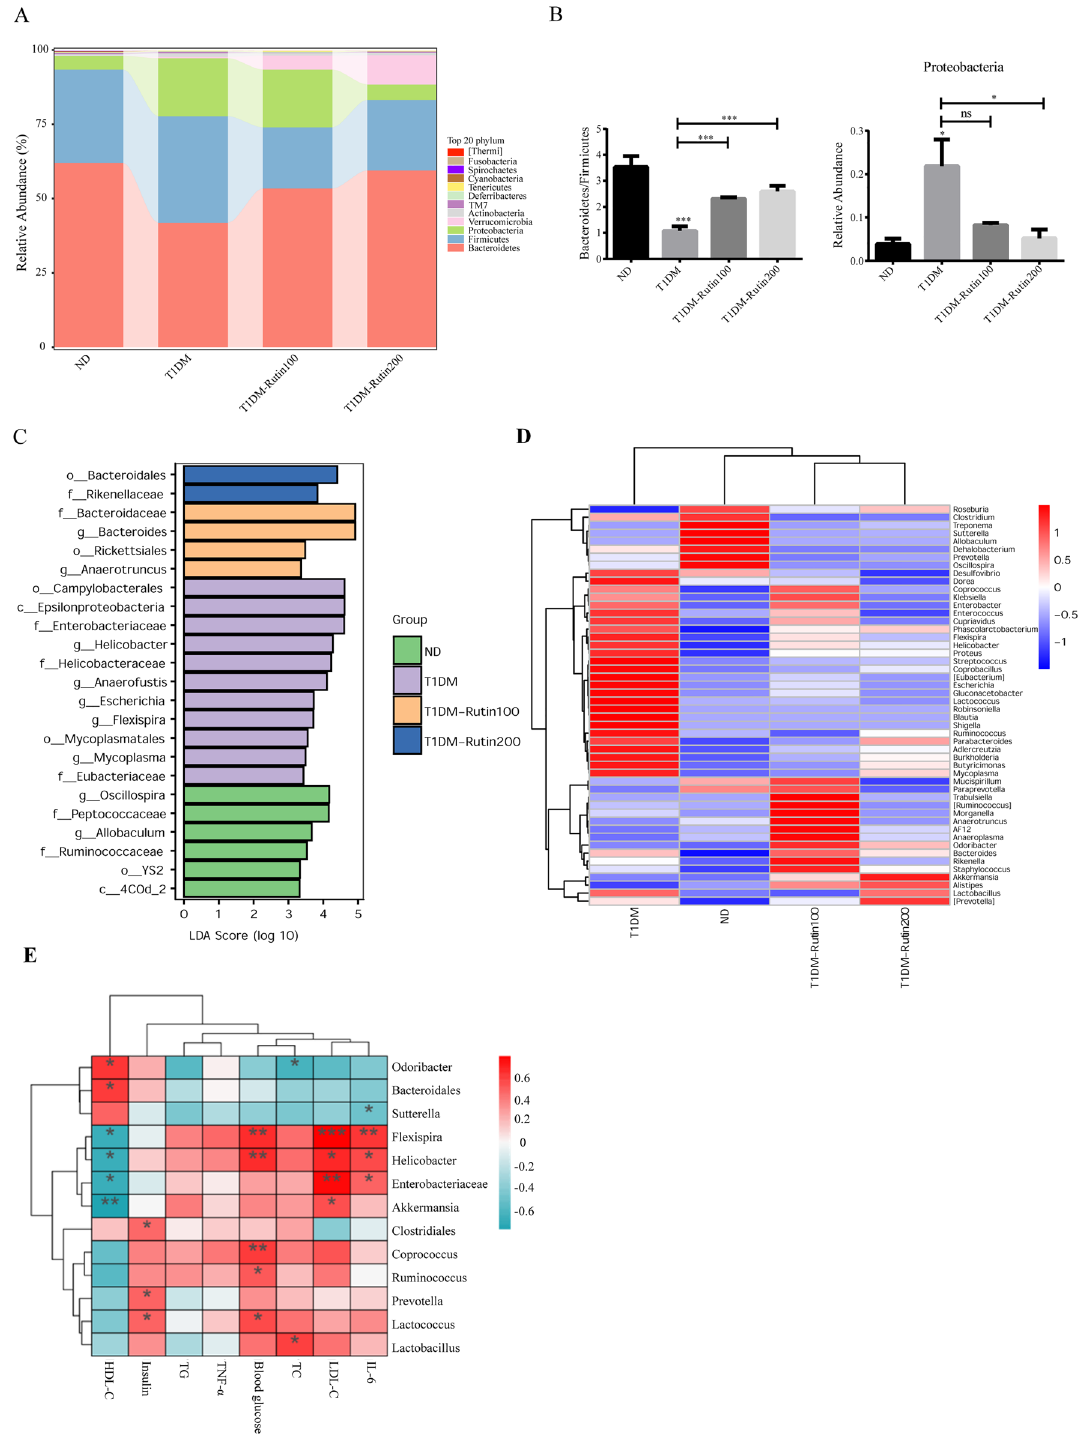
Figure 5. Effects of rutin on the gut microbiota composition in T1DM mice. ( A ) The relative abundances of gut microbiota constituents at the phylum level. ( B ) Bacteroidetes / Firmicutes in feces of mice and relative abundance of Proteobacteria at the phylum level. ( C ) LEfSe analysis of gut microbiota in the ND, T1DM, T1DM-Rutin100, and T1DM-Rutin200 groups. LDA scores > 2 and P < 0. 05 are the taxonomic groups with significant differences between groups. ( D ) Heatmap of the relative abundance of gut microbiota at the genus level. Each column in the plot represents a sample, and each row represents the community structure. The color represents the relative abundance of the species. The heatmap was created using Sangerbox 3.0 (http:// vip. sange rbox. com/). ( E ): Spearman’s correlation analysis of gut microbiota and metabolic parameters. Values are means ± SD (n = 5): *p < 0.05, **p <